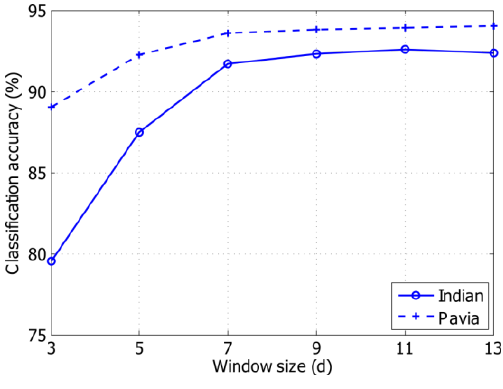
Figure 5. Classification accuracy (%) versus varying search-window size ( d ) for the proposed MH-KELM using 20 labeled samples per class for two experimental